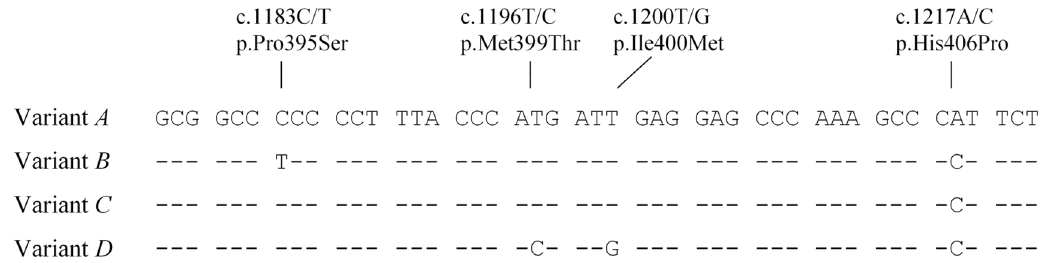
Figure 2. Sequence variation in the sixth coding exon of bovine LPIN1 . Four variant sequences ( A to D ) containing four non-synonymous single nucleotide polymorphisms are identified and only the variable regions of the sequences are shown. Dashes represent nucleotide sequences identical to the top sequence.